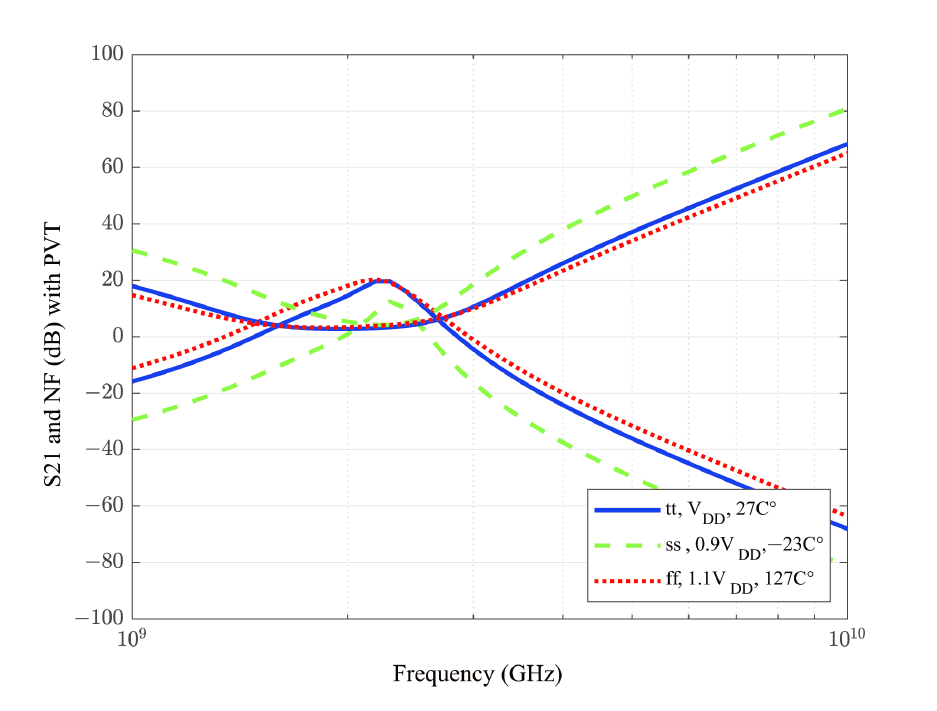
Figure 10. S21 and NF (dB) with PVT vs. frequency.